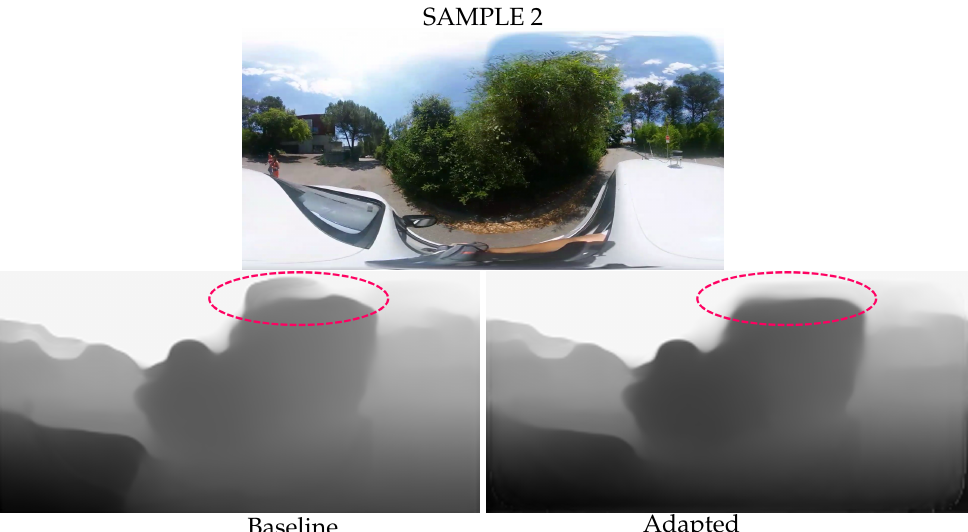
Figure 8. Less erroneous depth estimation from the adapted network. A red circle at the top of the image highlights the area with the most visible differences.